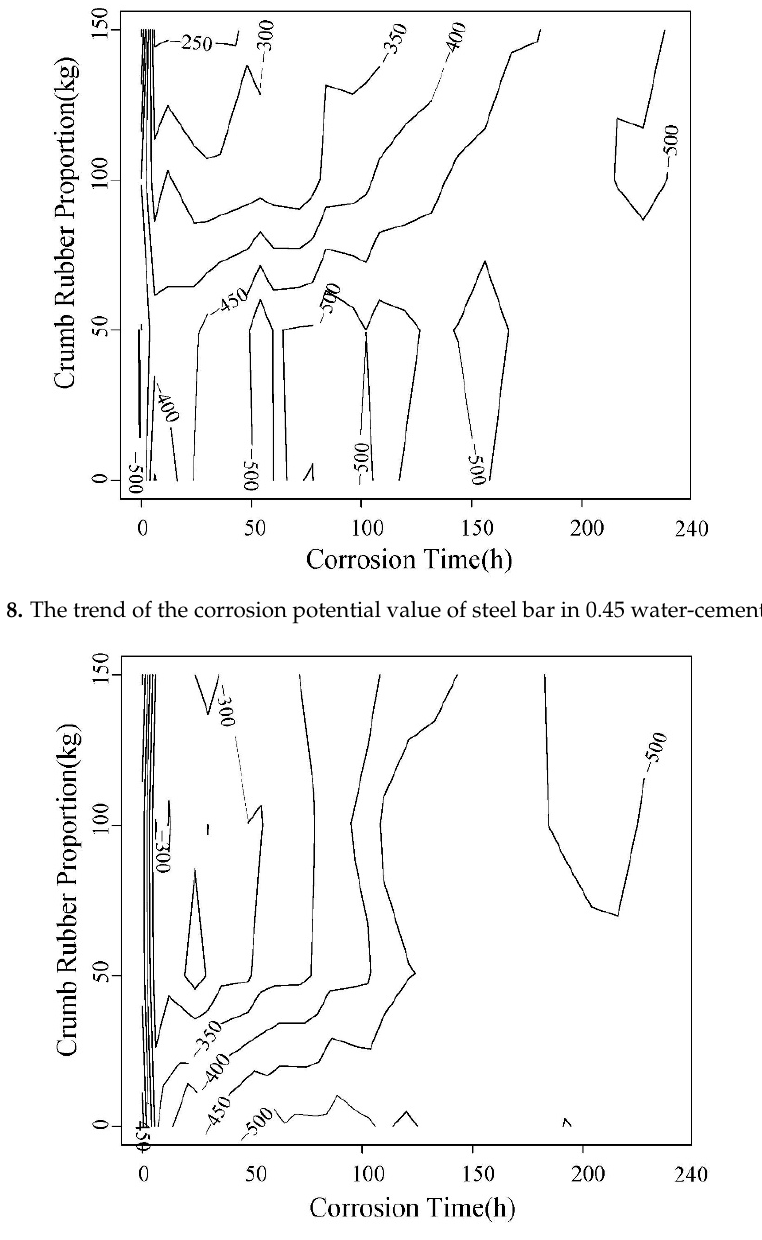
Figure 9. Trend of corrosion potential value of steel bar in 0.55 water-cement ratio.